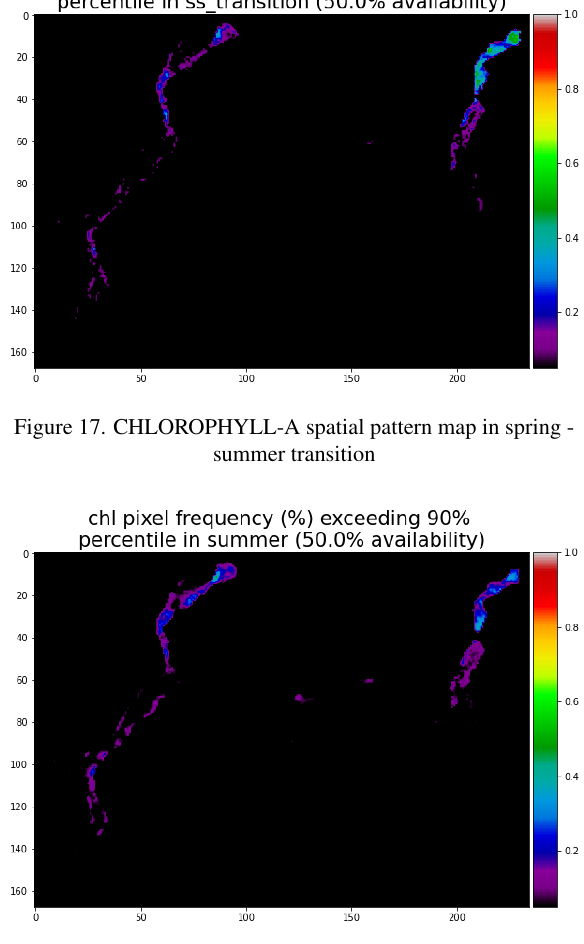
Figure 18. CHLOROPHYLL-A spatial pattern map in summer Lake Water Surface Temperature